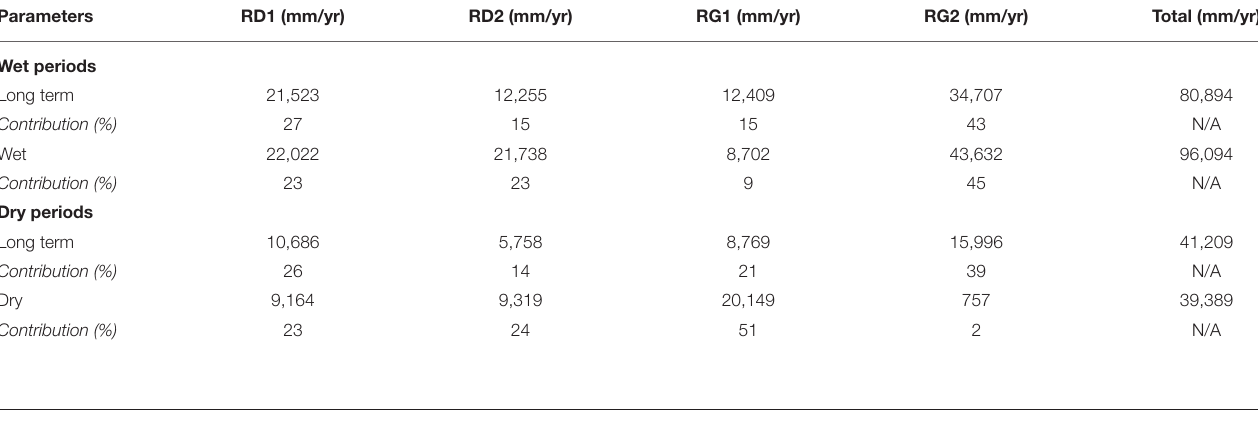
TABLE 4 | A summary of the total flow contribution and the percentage of simulated surface runoff (RD1), interflow (RD2), fast groundwater (RG1) and slow groundwater (RG2) using the parameters θ long − term , θ wet and θ dry for wet periods (1983–1997, 1999, 2001–2002, and 2005–2010) and dry periods (1995, 1998, 2000, 2003–2004, and 2011).